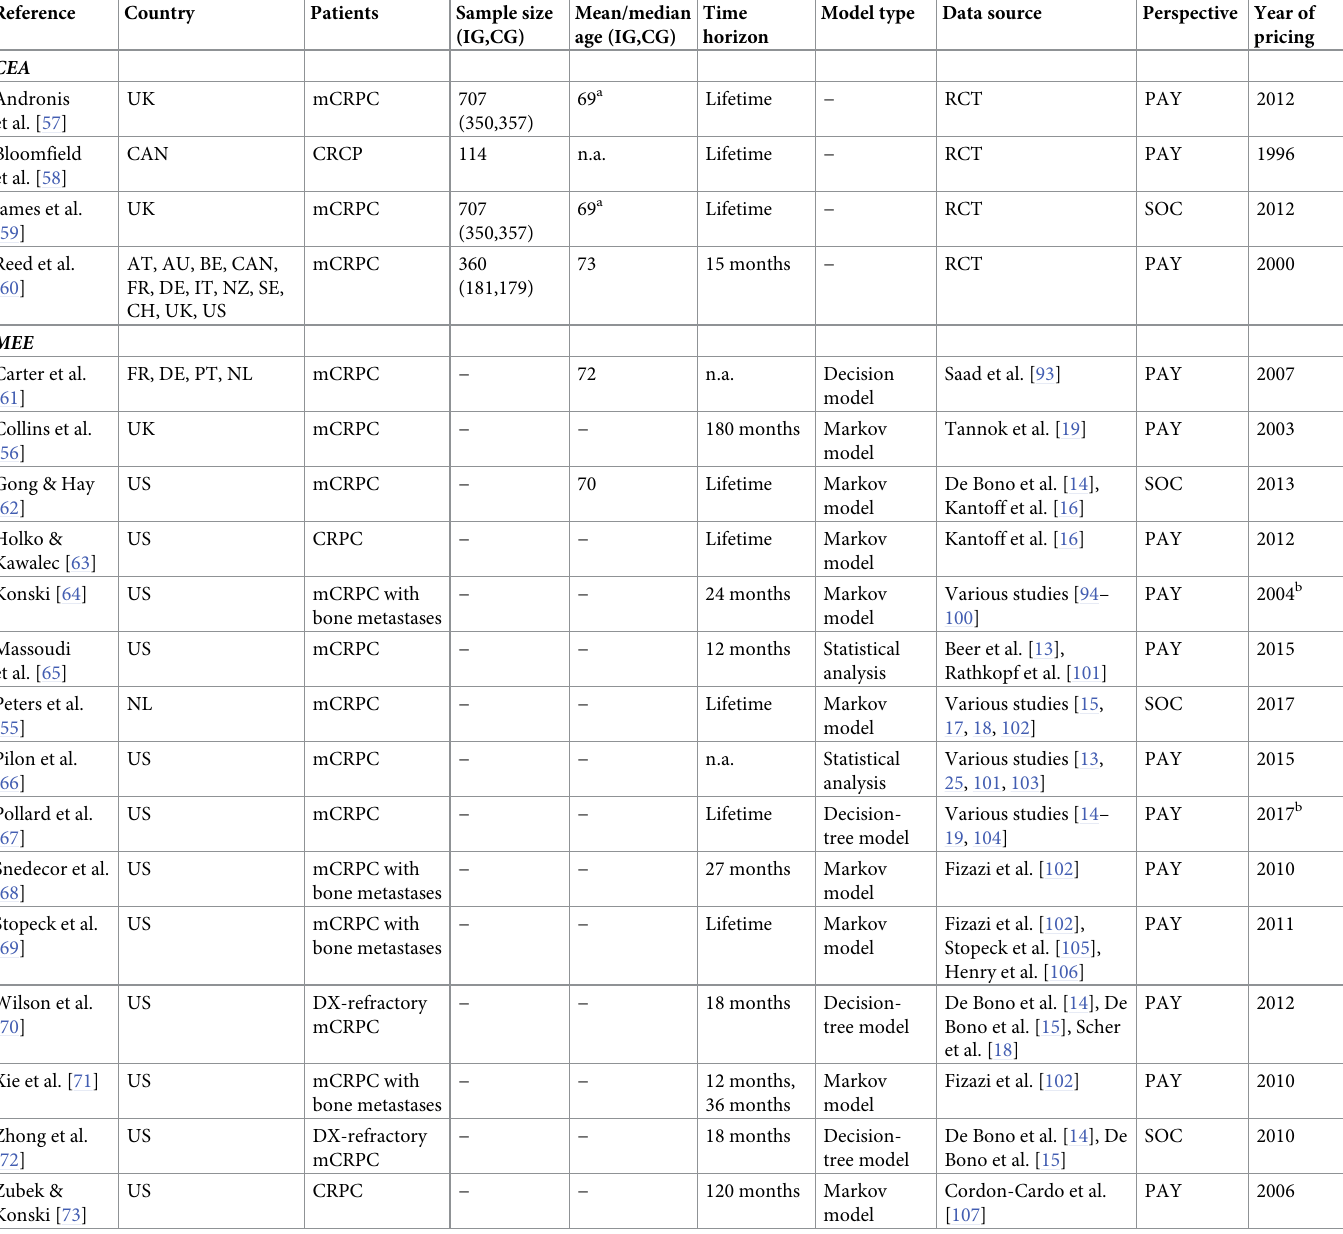
Table 1. General characteristics of included cost-effectiveness analyses and model-based economic